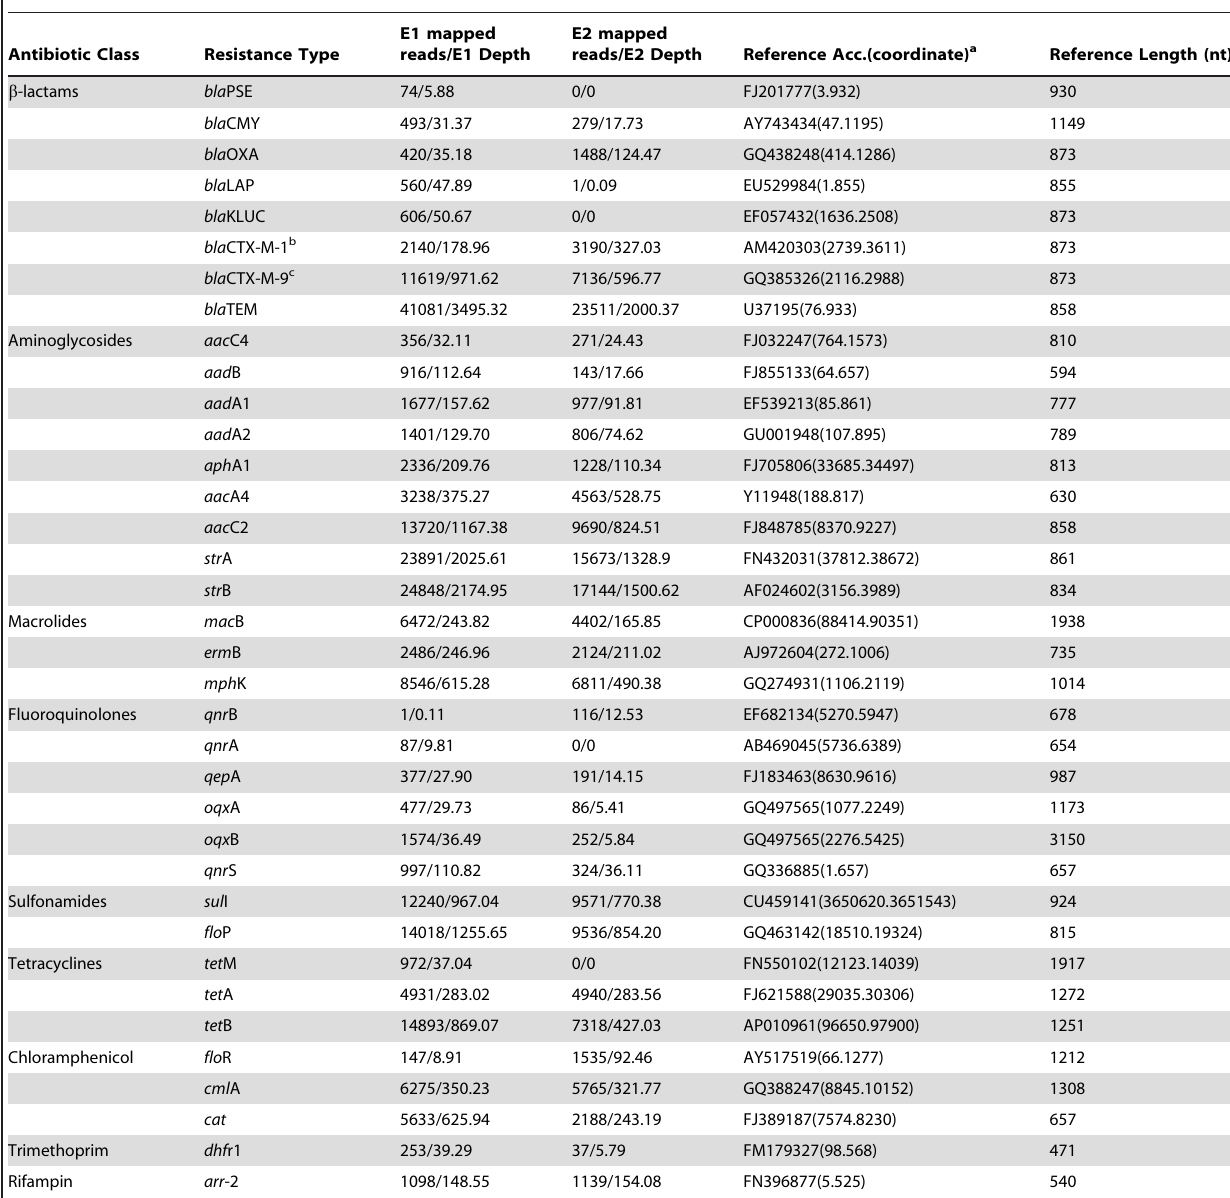
Table 1. The emerging resistance genotypes, redundancy and references in the two samples.